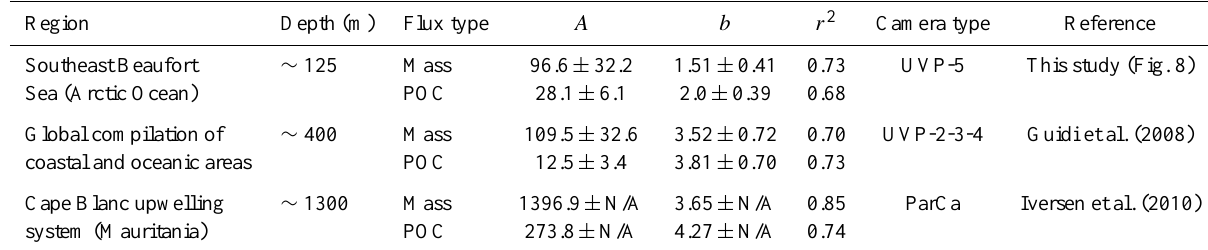
Table 2. Constant ( A) and scaling exponent ( b) of the empirical power-law relationships (±standard deviation) computed by the Nelder- Mead simplex minimization procedure between particle size determined by underwater cameras and the corresponding mass and particulate organic carbon (POC) fluxes measured with in situ sediment traps. The associated coefficients of determination ( r 2 ) describe the fits between the estimated fluxes using empirical equations and the sediment trap fluxes. See also Appendix A for a sensitivity analysis conducted on the A and b parameters. N/A: not